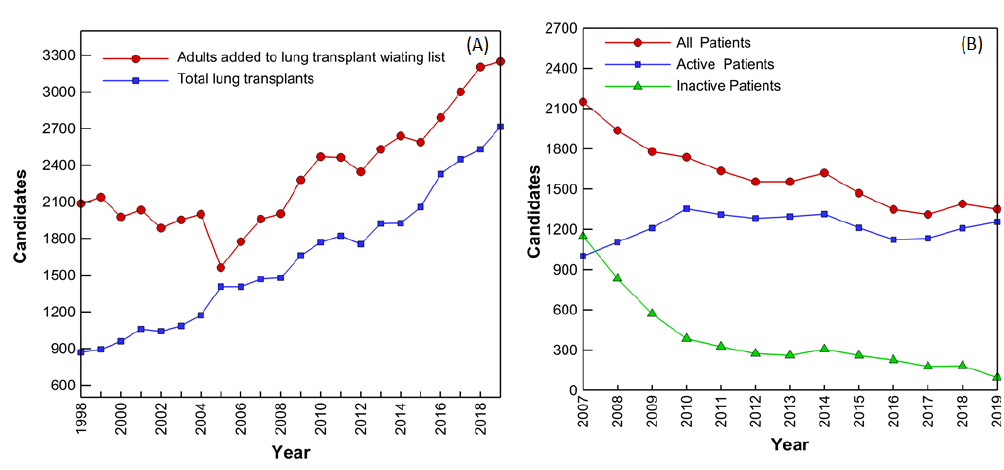
Figure 1. ( A ) Evolution of adult patient number added to the lung transplant waiting list and of total lung transplants since 1998 [1,2]. ( B ) Evolution of adult candidate number waiting for lung transplant [1]